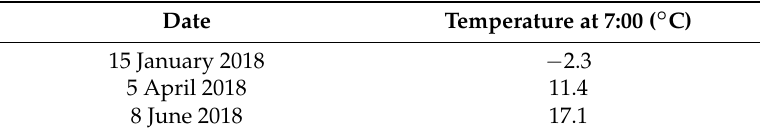
Table 1. Measurements on the runway were performed in three time periods and measured in degrees Celsius ( ◦